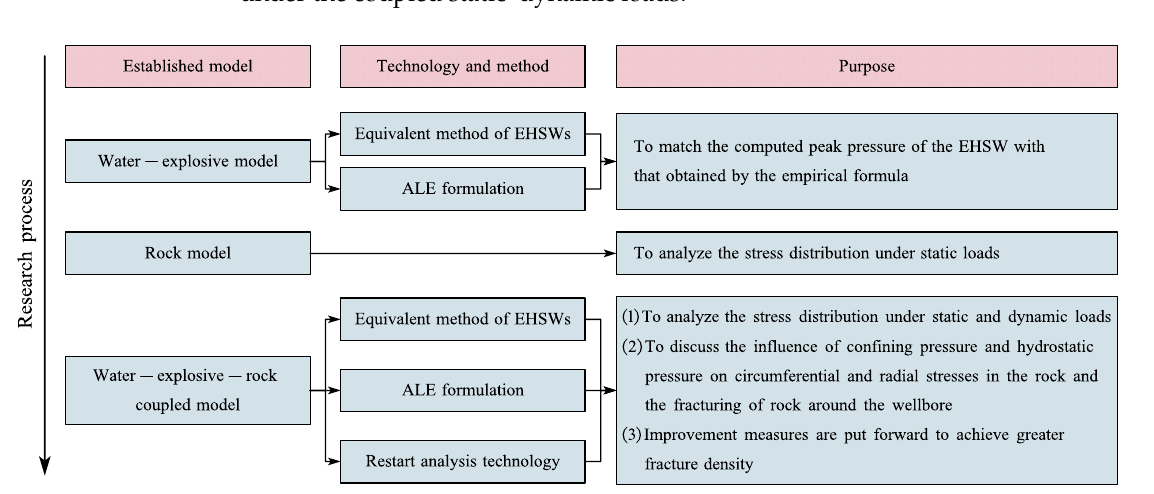
Figure 1. The flowchart of the research process in this paper.